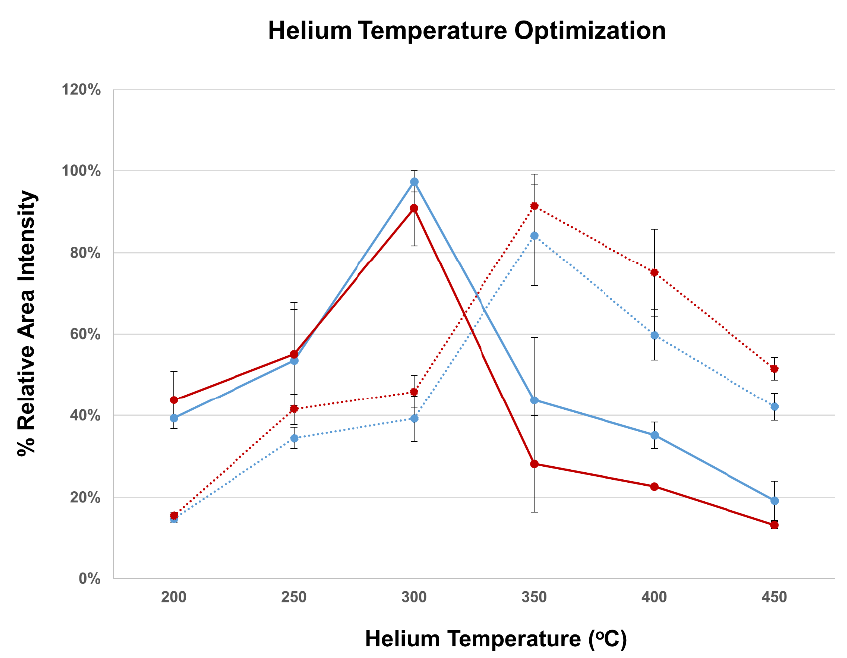
Figure 3. DART helium gas temperature optimization in QqQ-MS/MS for DON (blue) and 3-AcDON (red) 60 ng/mL, in MeOH/NH 3 2% v / v (solid line) and MeOH/NH 3 2% v / v exposed to the ID-LFIA substrate (dotted line). Measurements were performed in duplicate by MRM monitoring of the ion transitions specified in Table 1. The standard deviation of the duplicate measurement is shown by the error bars. The results are presented as the relative (%) area intensity, i.e., the ratio of the absolute area intensity divided by the highest absolute area intensity observed for each substance in each solution.